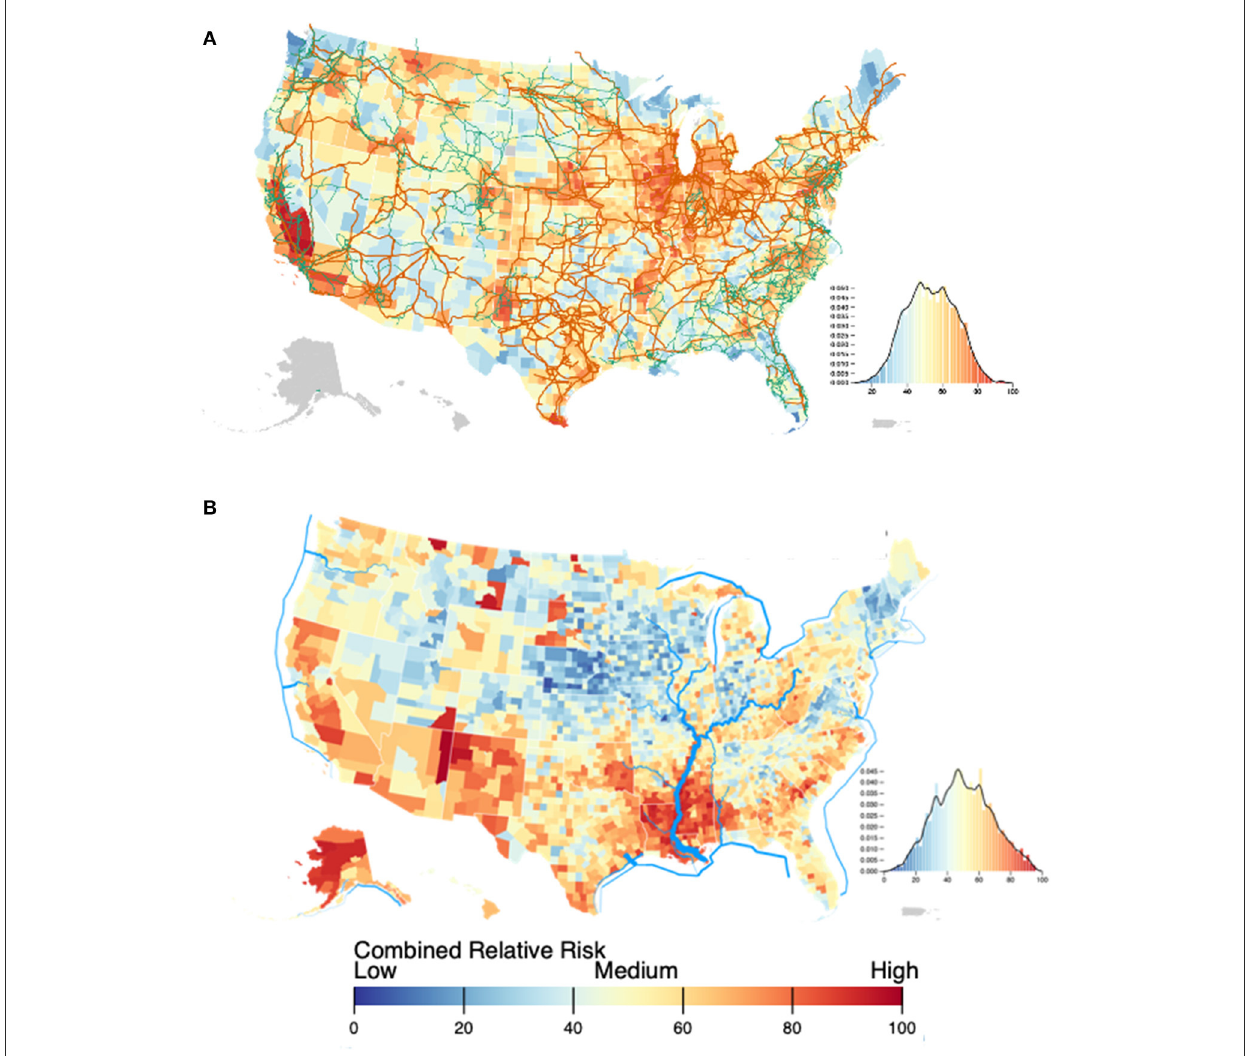
FIGURE4 Maps produced from the STRESS platform illustrate the “hotspot” visualization and analysis capability of the user-defined, use-inspired interface. Panel (A) shows the result of quantitatively combining the current level of risks in water availability and quality, land disturbance, and exposure to poor air quality. Orange and red shades indicate “hotspot” areas of these three risks co-existing to the highest degree relative to all U.S. counties. Also shown is the graphical overlay of high-voltage transmission lines (green ≥ 230 kV and orange ≥ 345 kV) across the nation’s energy grid. Panel (B) shows the result of combining risk metrics that convey the current levels of employment in fossil energy as well as demographic metrics of poverty, unemployment, and non-white population. Also shown as an overlay (blue lines) is the extent of major riverine and marine “highways” with the thickness of the lines depicting the relative total value of goods transported (coal, petro, food, chemical, manufacturing, and raw materials).